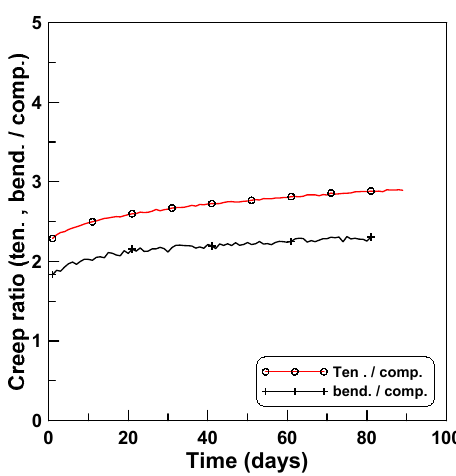
Figure 14. Ratios of bending creep to compression creep.